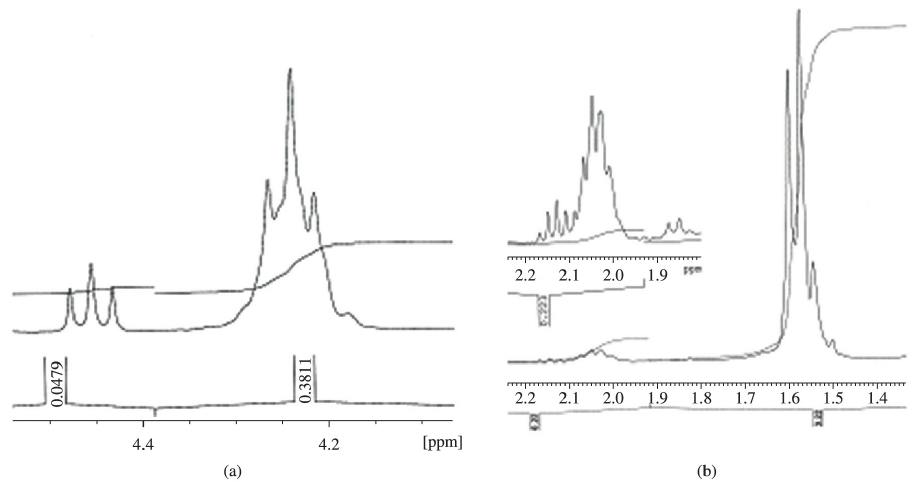
Figure 4. Amplification of the regions corresponding to the protons peaks of TMC in the H 1 -NMR spectra of PLDLA-TMC synthesized with 30% TMC. (a) and (b) - Proton peaks corresponding to OCH